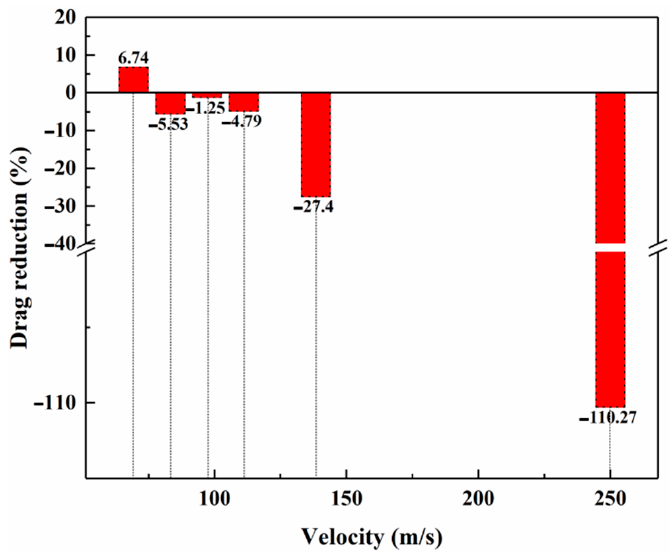
Figure 2. The relationship between flow velocity and drag reduction